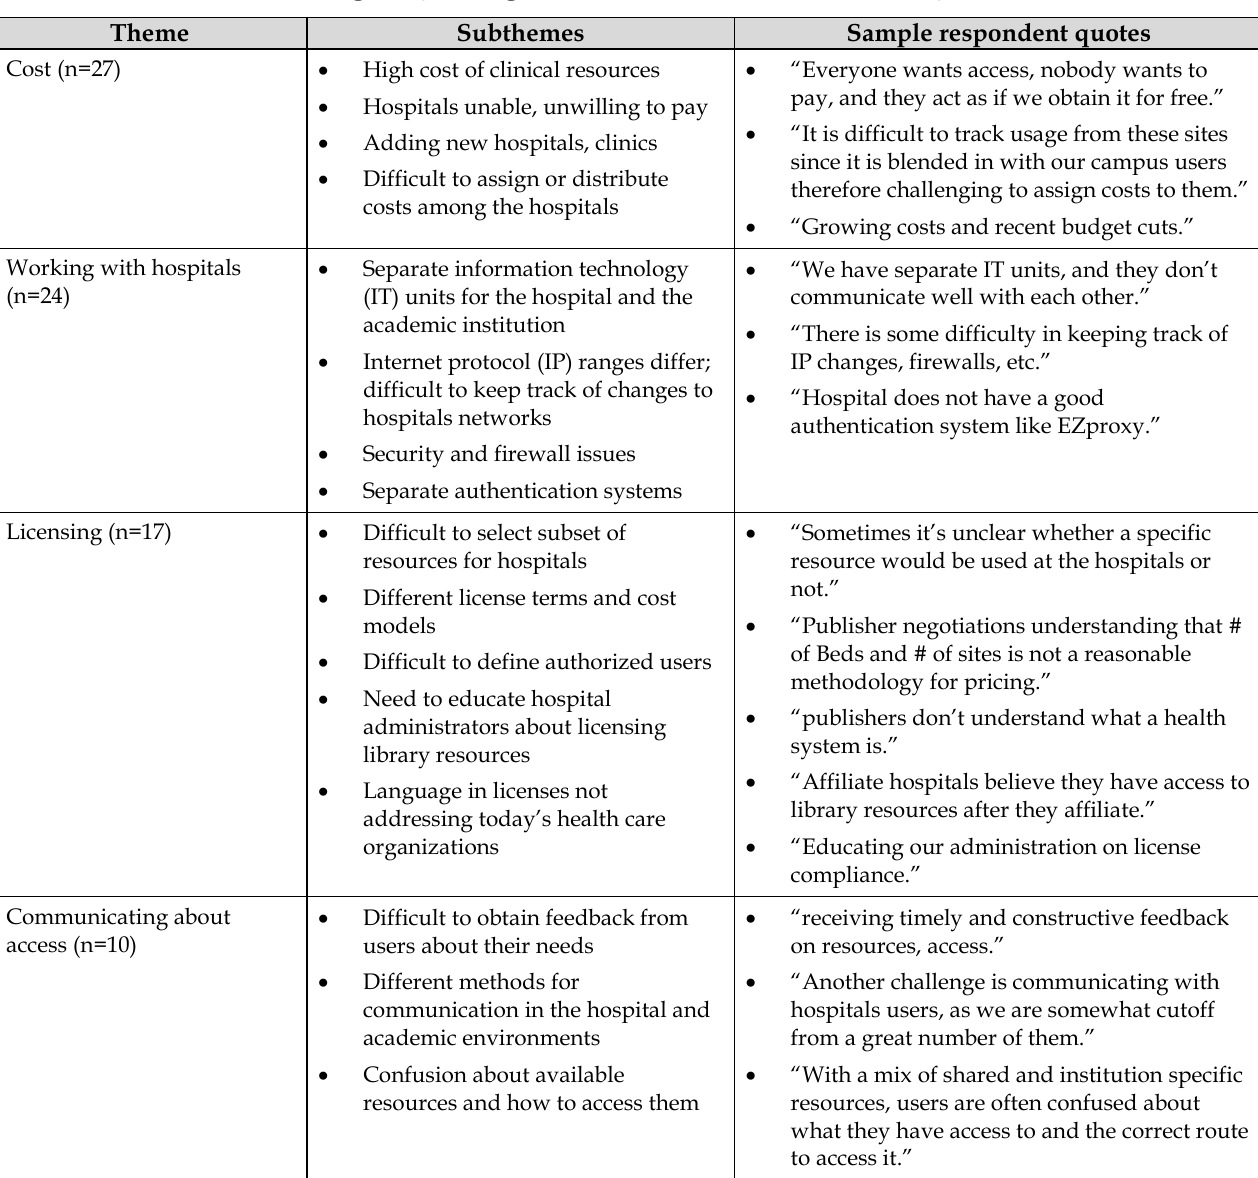
Table 3 Themes related to challenges in providing online resource access to affiliated hospitals